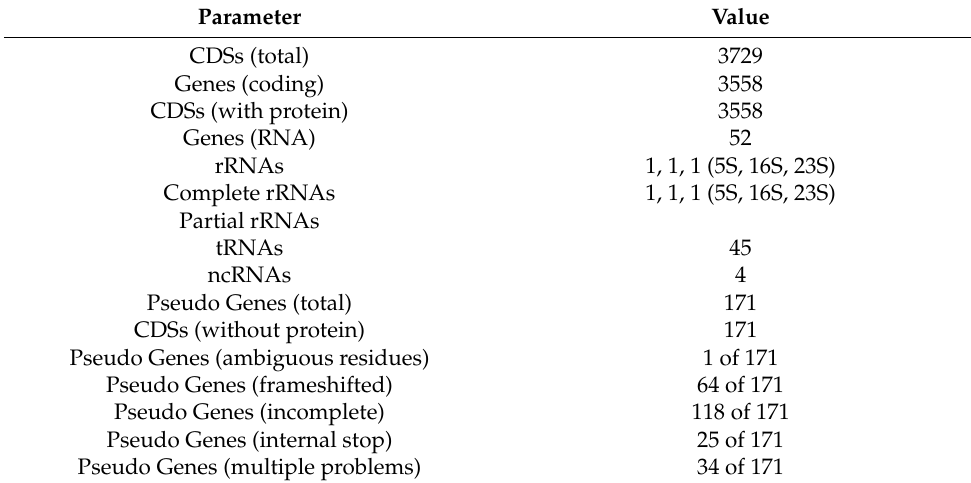
Table 2. Results of the strain TFBk genome